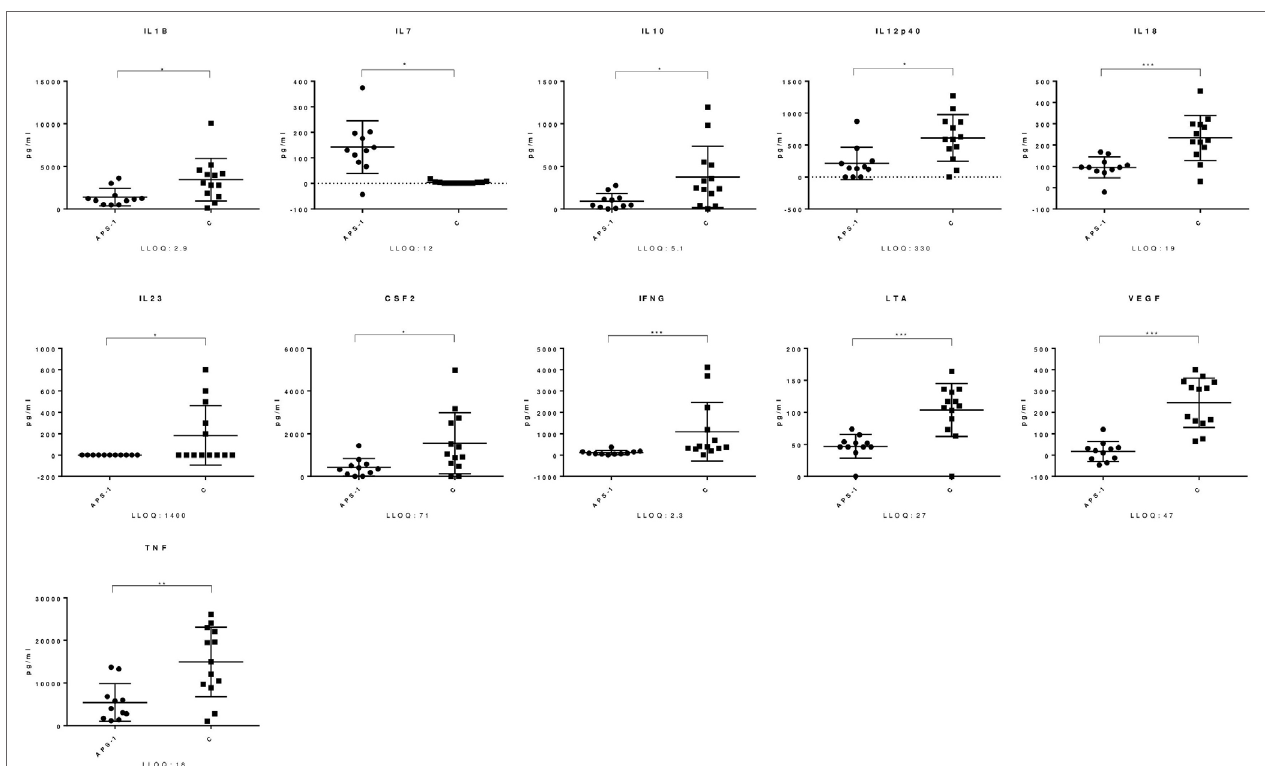
FigUre 1 | Mediators with significant different response in Autoimmune polyendocrine syndrome type 1 (APS-1) and controls. The figure shows selected mediators from the TrueCulture assay and significant differences were found comparing APS-1 and controls (C). The lines indicate the mean with standard deviation. Concentrations are given at the y -axis. LLOQ, lower limit of quantitation. * P ≤ 0.05; ** P ≤ 0.01; *** P ≤